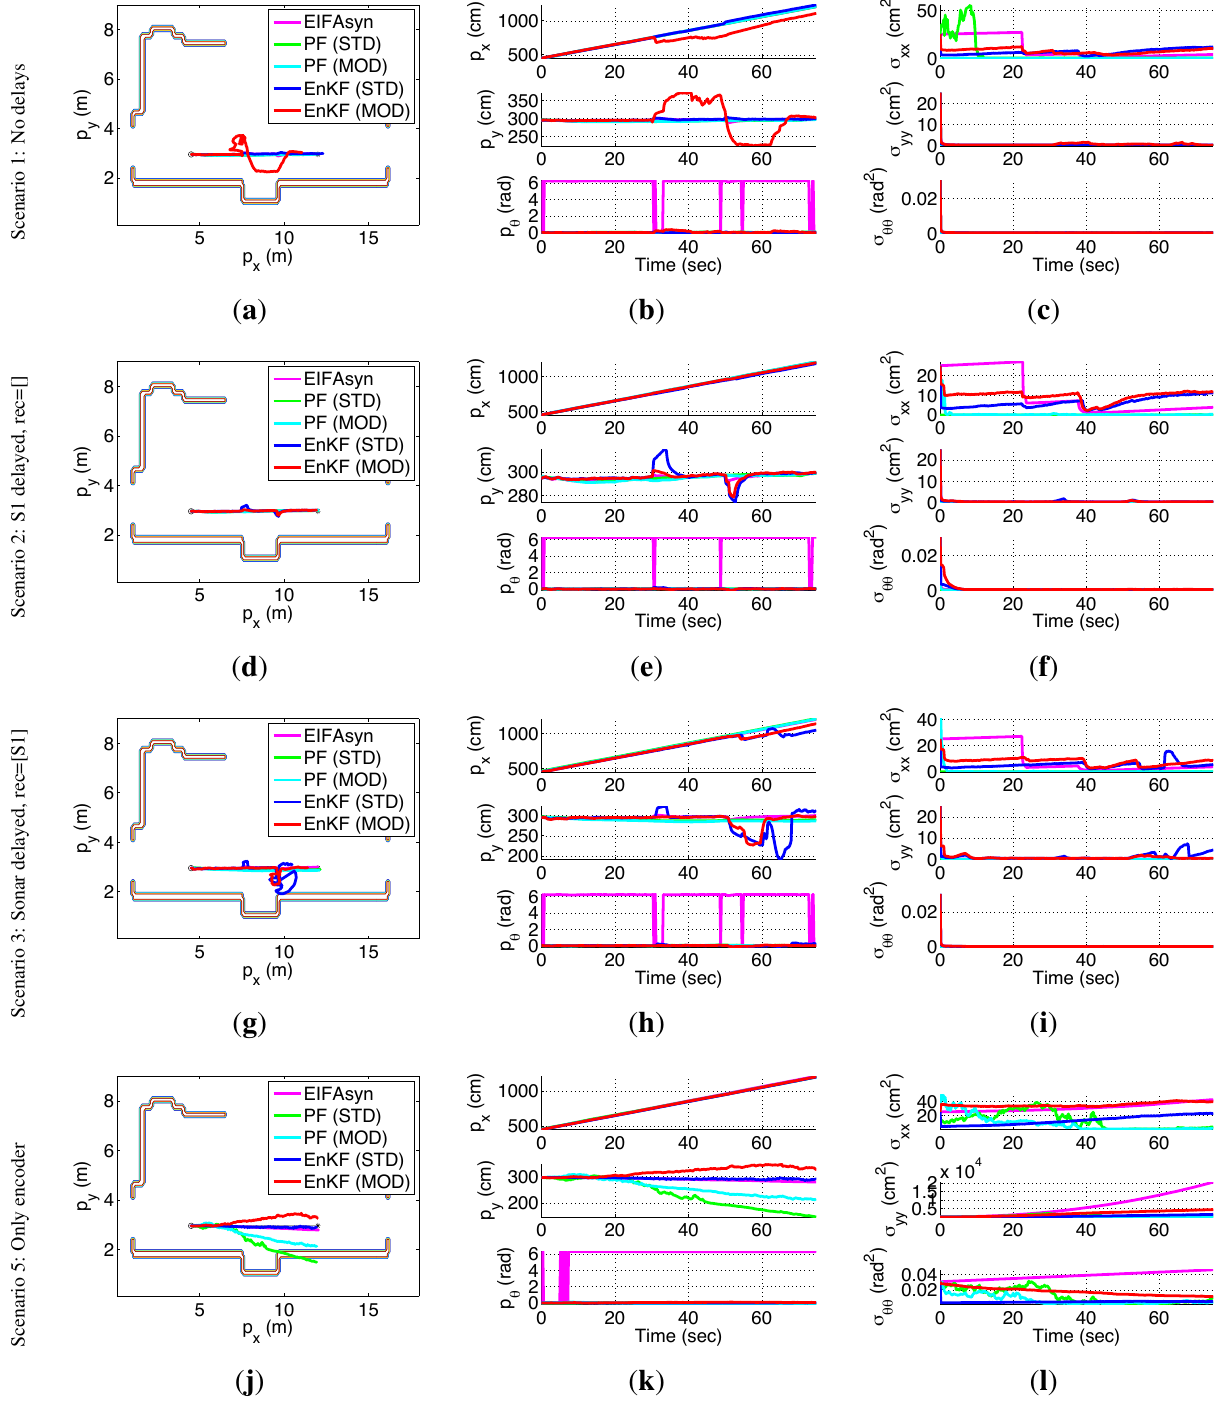
Figure 8. OOS Approaches